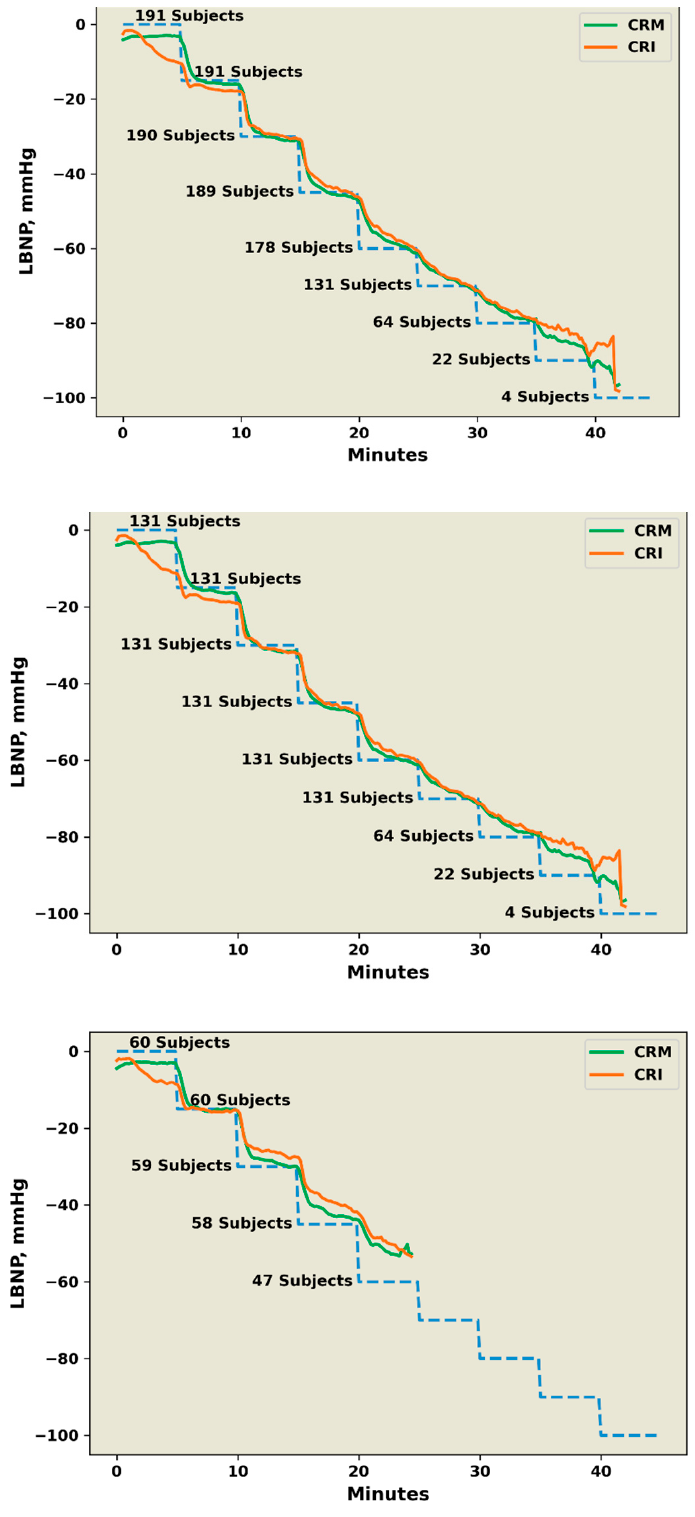
Figure 3. Average responses of compensatory reserve estimated by the CRI (orange line) and CRM (green line) algorithms for all 191 subjects ( upper panel), 131 high-tolerance subjects ( middle panel B), and 60 low-tolerance subjects ( lower panel). The LBNP profile steps used for model development as a target of reduced central circulating blood volume are indicated by the blue broken line (labeled on the y -axis).